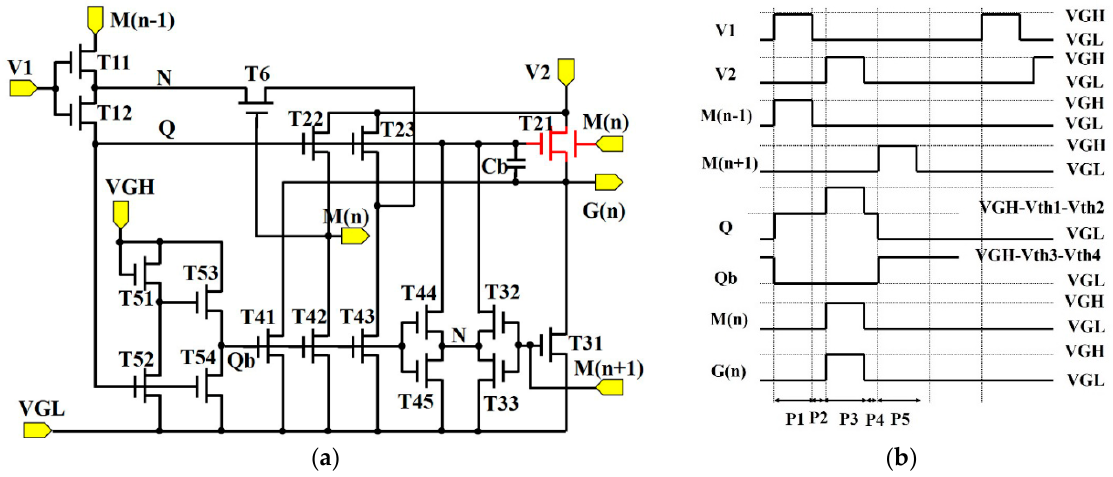
Figure 4. ( a ) The schematic diagram and ( b ) operation waveform of the proposed shift register circuit.